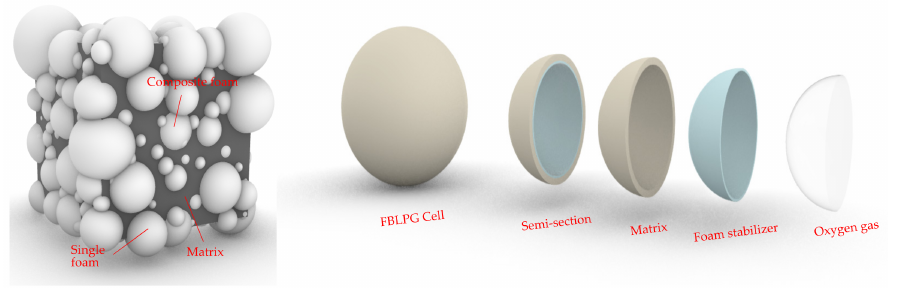
Figure 1. The model for the structure of the FBLPG slurry.